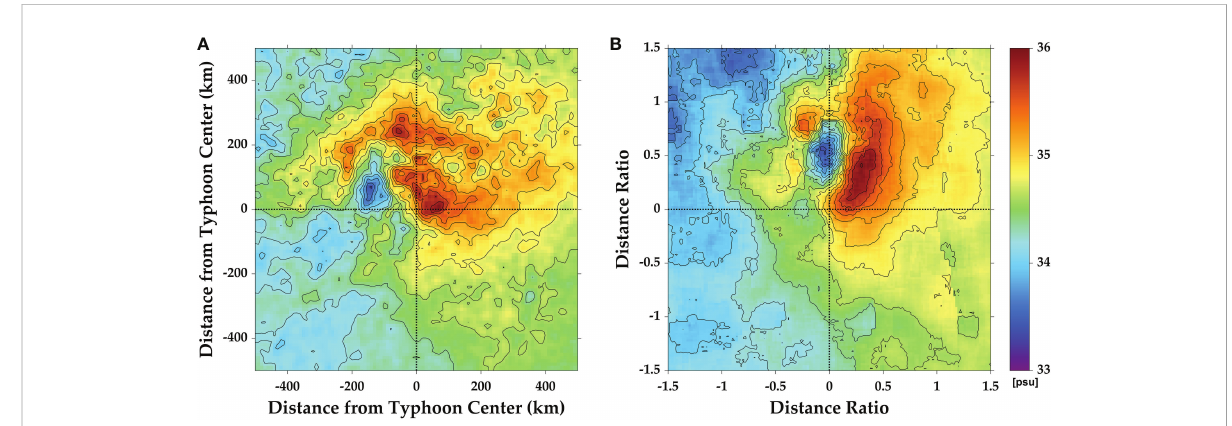
FIGURE 15 Spatial distributions of sea surface salinity (psu) responses in (A) non-rotated and (B) rotated coordinates in the direction of typhoons as a function of distance ratio from the typhoon center in the Northwest Paci fi c using SMAP